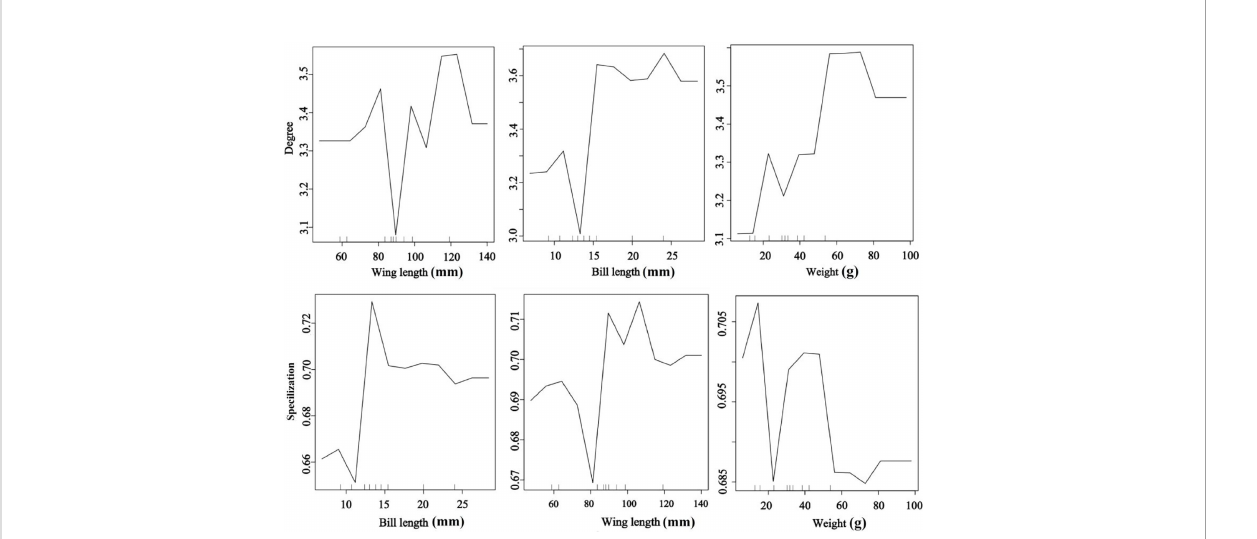
FIGURE 4 Effects of bird traits on the network metrics at the species level (degree and specialization) representing a fragmented forest in Southeast China. Results were determined using the Random Forest algorithm and showed the partial effects of independent variables on degree and specialization, respectively.